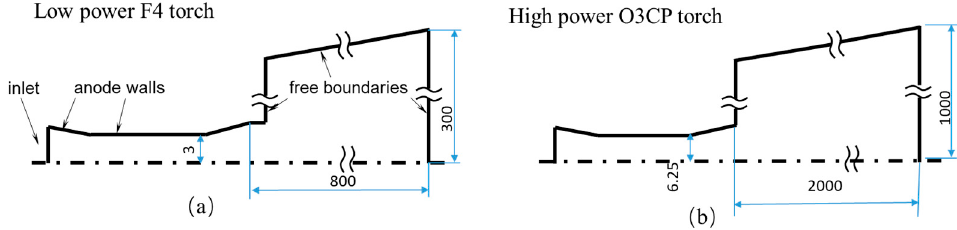
Figure 3. Computational domains: ( a ) low-power (F4), and ( b ) high-power plasma torch (O3CP). All the dimensions are expressed in mm.